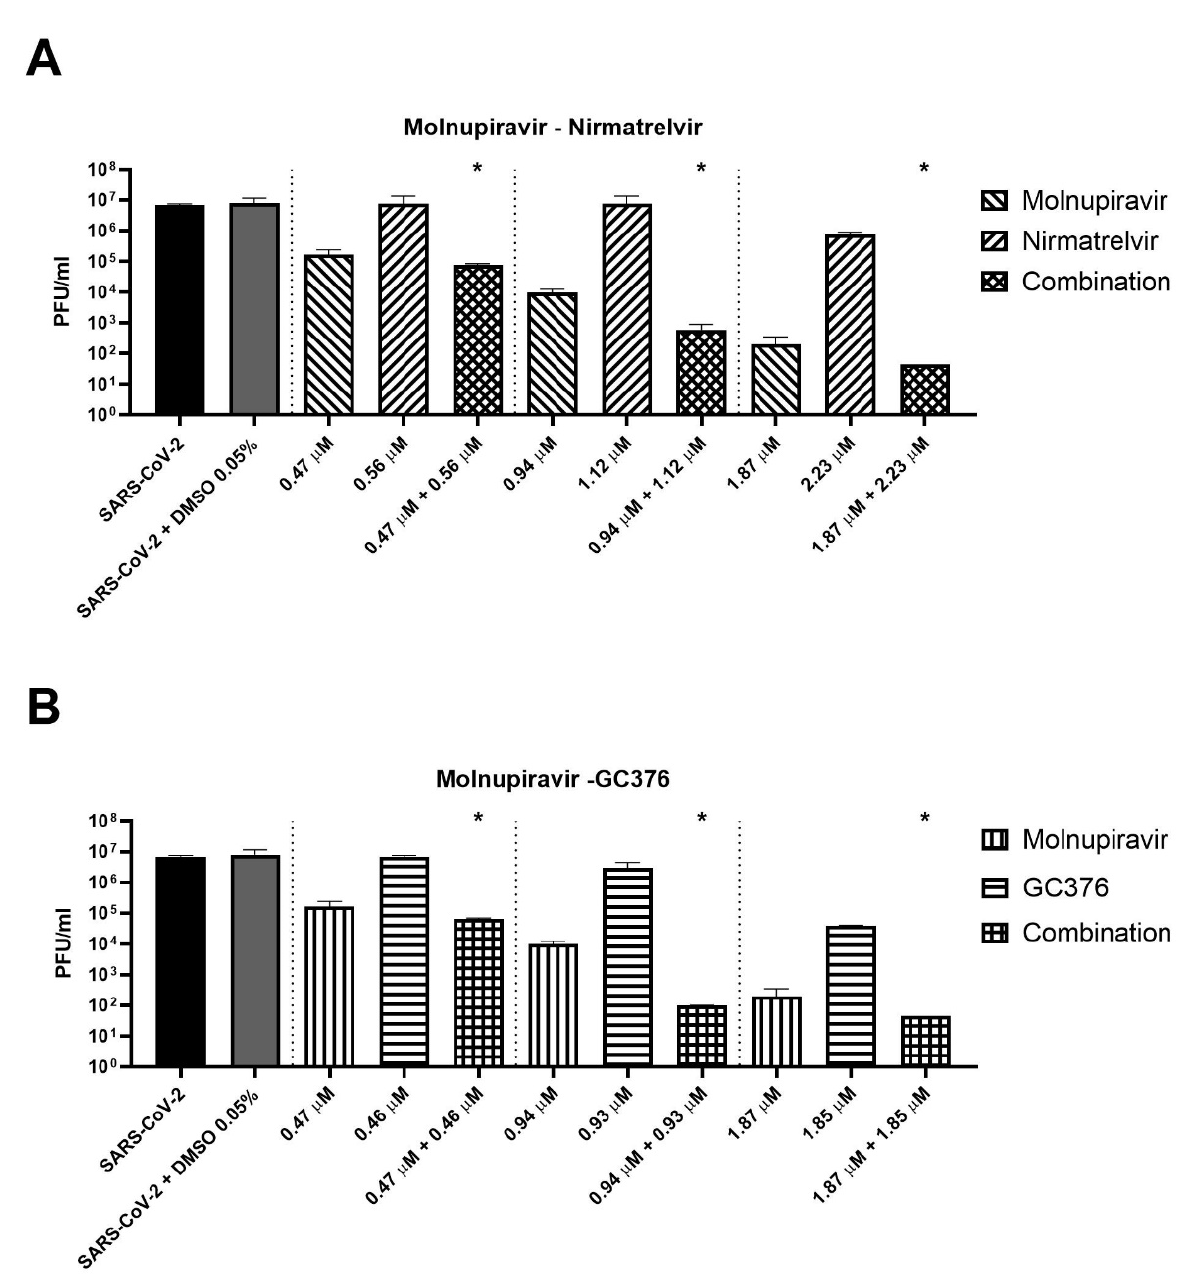
Figure 3. Plaque-reduction assay of the selected combination of antivirals. After synergy tests, supernatants of SARS-CoV-2 20A.EU1 infected Vero E6 cells treated with combinations of antivirals were frozen and selected concentrations of ( A ) molnupiravir–nirmatrelvir and ( B ) molnupiravir– GC376 were tested for viral load by plaque assay. Viral titers are expressed as mean ± SD of plaque-forming units (PFU)/mL from one experiment performed in triplicate. * p < 0.05, antiviral combination vs. more active single agent.